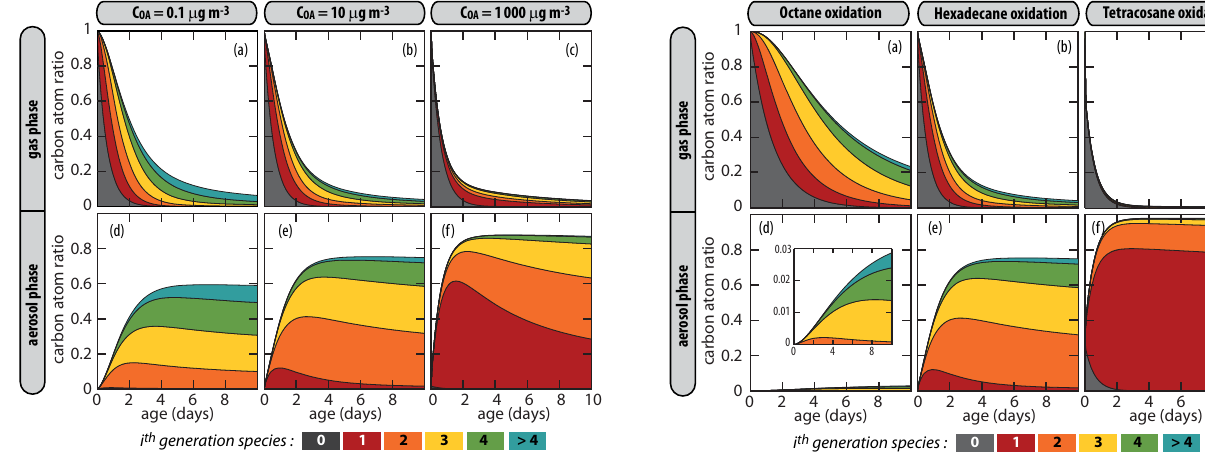
Fig. 4. Partitioning of organic carbon during octane, hexadecane and tetracosane oxidation in the gas and aerosol phases. Colors identify the contribution of the species from a given generation to the total carbon budget. The inset in (d) shows the carbon atom ratio with an expanded scale.